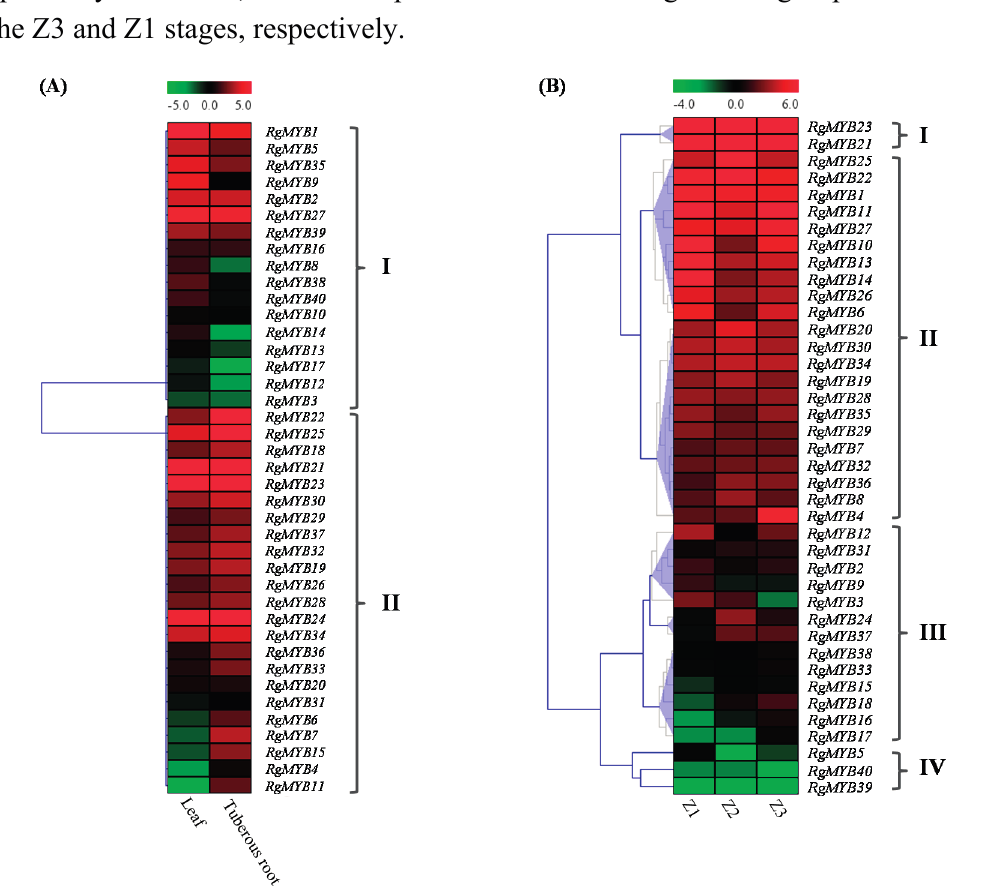
Figure 4. Expression profiles of 40 R. glutinosa MYB family genes in different tissues/developments. ( A ) Expression levels of 40 MYBs in leaves and tuberous roots; ( B ) Expression levels of 40 MYB genes in tuberous roots at different stages. The color bar presented expression level of genes: green shows the low expression, and red color shows high expression level. Z1, Seedling stage; Z2, Elongation stage of tuberous root; and Z3, Pre-expanding stage of tuberous root. The heat maps were generated by MultiExperiment Viewer